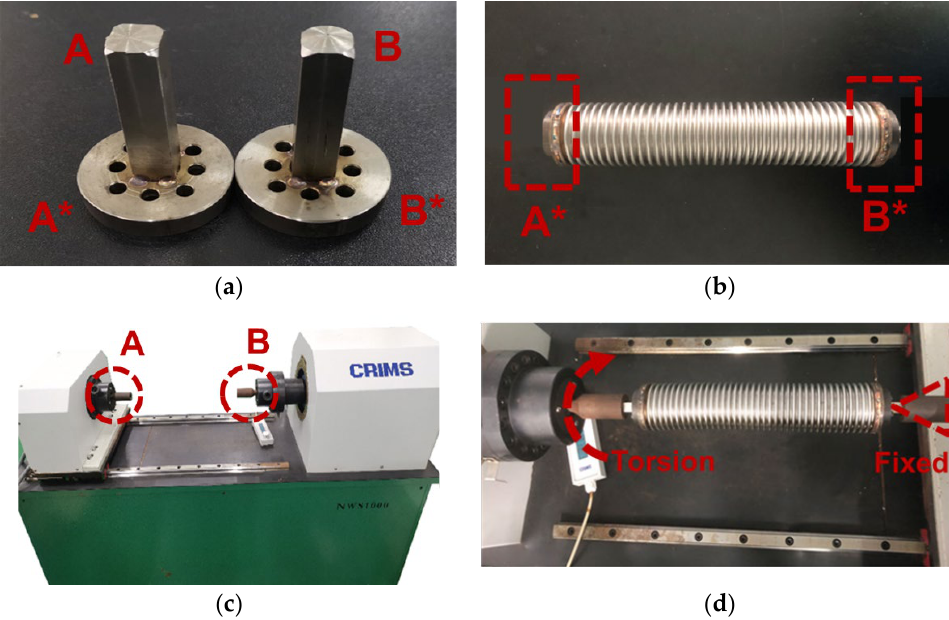
Figure 15. Toroid bellows and testing machine in the torsional buckling experiment; ( a ) two con- nectors of the toroid bellows, ( b ) experiment piece of toroid bellows, ( c ) torsion testing machine (CRIMS), and ( d ) toroid bellows in the testing machine. Table 4. Structural and material parameters of the experiment piece of toroid bellows. Table 4. Structural and material parameters of the experiment piece of toroid